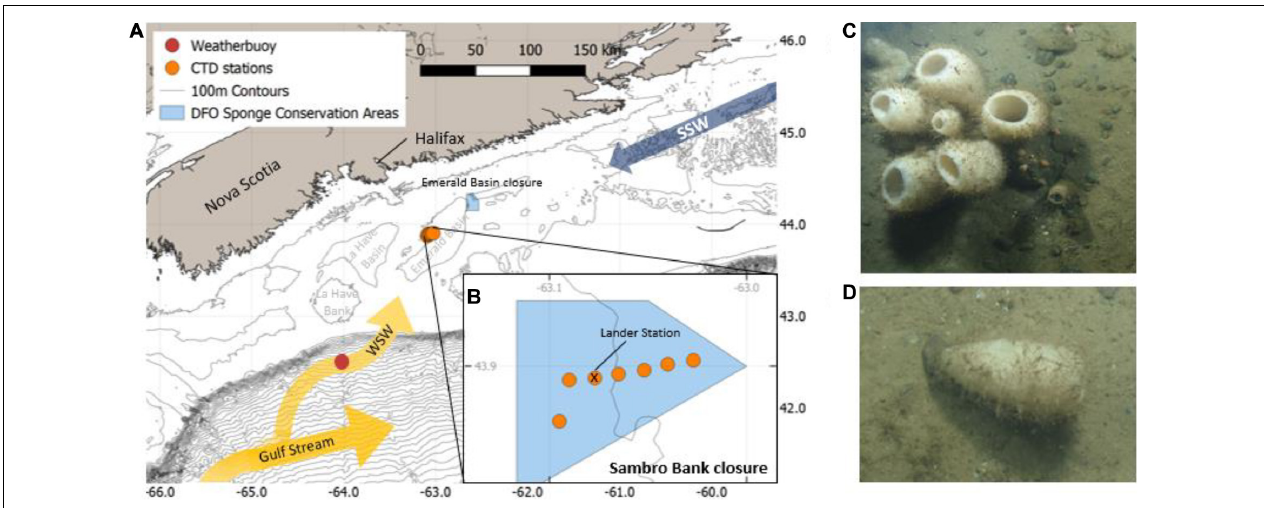
FIGURE 1 | (A) Scotian Shelf with CTD, weather buoy stations and both DFO Sponge conservation areas indicated in light blue. The arrows indicate the flow of the slope waters, WSW (orange arrow) and SSW (dark blue arrow), (B) Sambro Bank closure with CTD and lander stations; (C) V. pourtalesii sponges inside the Sambro Bank closure, (D) some sponges were found in a horizontal